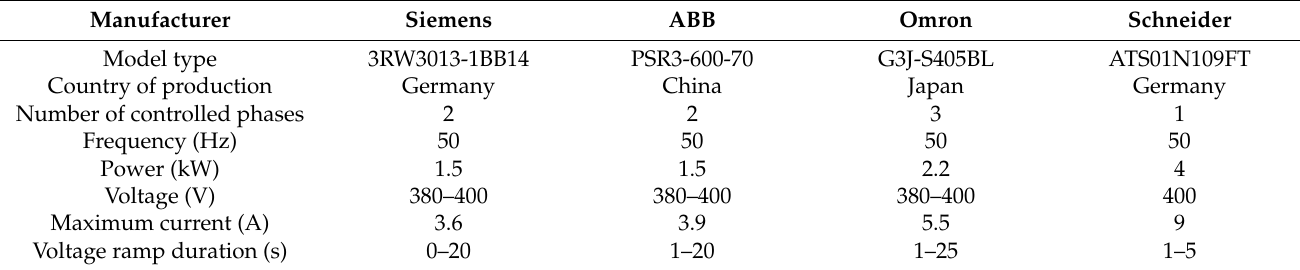
Table 3. Characteristics and rated values of the industrial soft-starters used during tests.